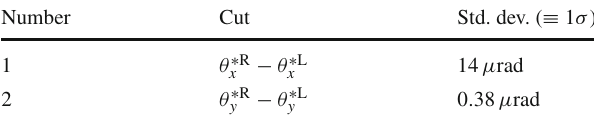
Table 2 The elastic selection cuts. The superscripts R and L refer to the right and left arm. The rightmost column gives a typical standard deviation of the cut